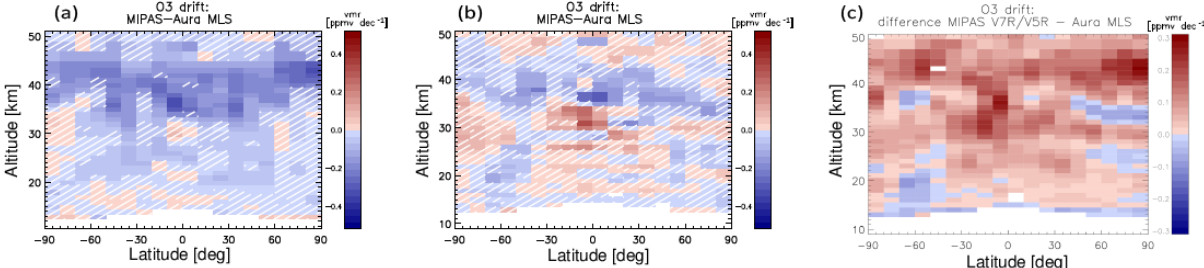
Figure 11. Altitude–latitude cross section of absolute drifts of MIPAS V5R (a) and V7R (b) vs. Aura MLS ozone measurements as well as their difference (c) . Hatched areas mean that the significance is less than 2 σ .